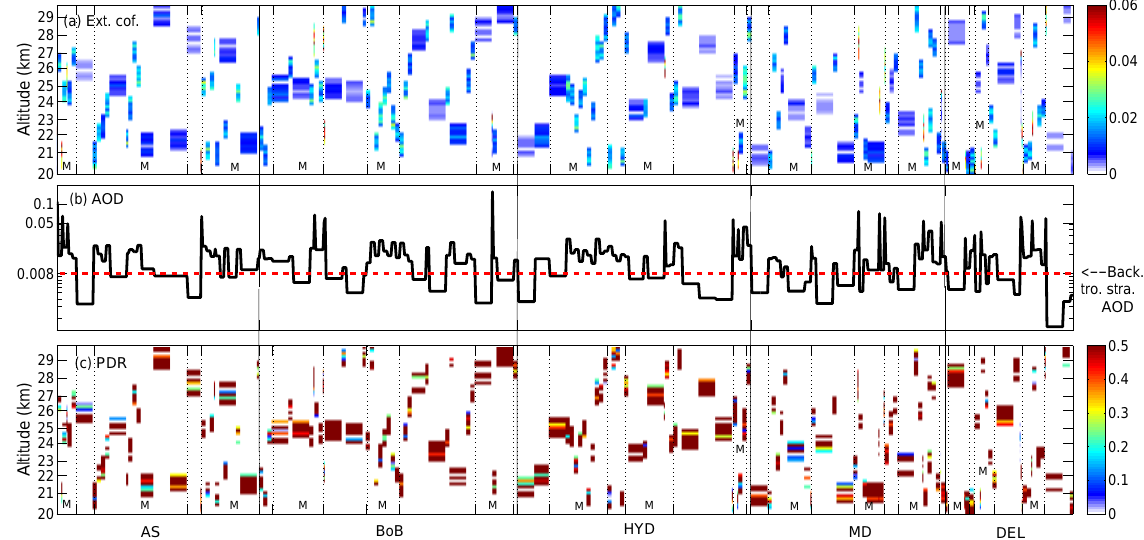
Figure 12. Time series of the vertical profile of the (a) extinction coefficient over five regions (AS is the Arabian Sea, BoB is the Bay of Bengal, HYD is Hyderabad, MD is Mumbai and Delhi and DEL is Delhi) over and around India (b) . Corresponding stratospheric (from 20 to ∼ 30km) AOD; the background stratospheric AOD for the entire tropical belt (Kremser et al., 2016) is shown by the dotted red line (c) . Particle depolarisation ratio (PDR) over the same five regions from January 2010 to December 2012. The individual time series of the extinction coefficient, AOD and PDR of each region are appended together in the figure one after the other. The letter M signifies the monsoon (JJAS) season during the year under